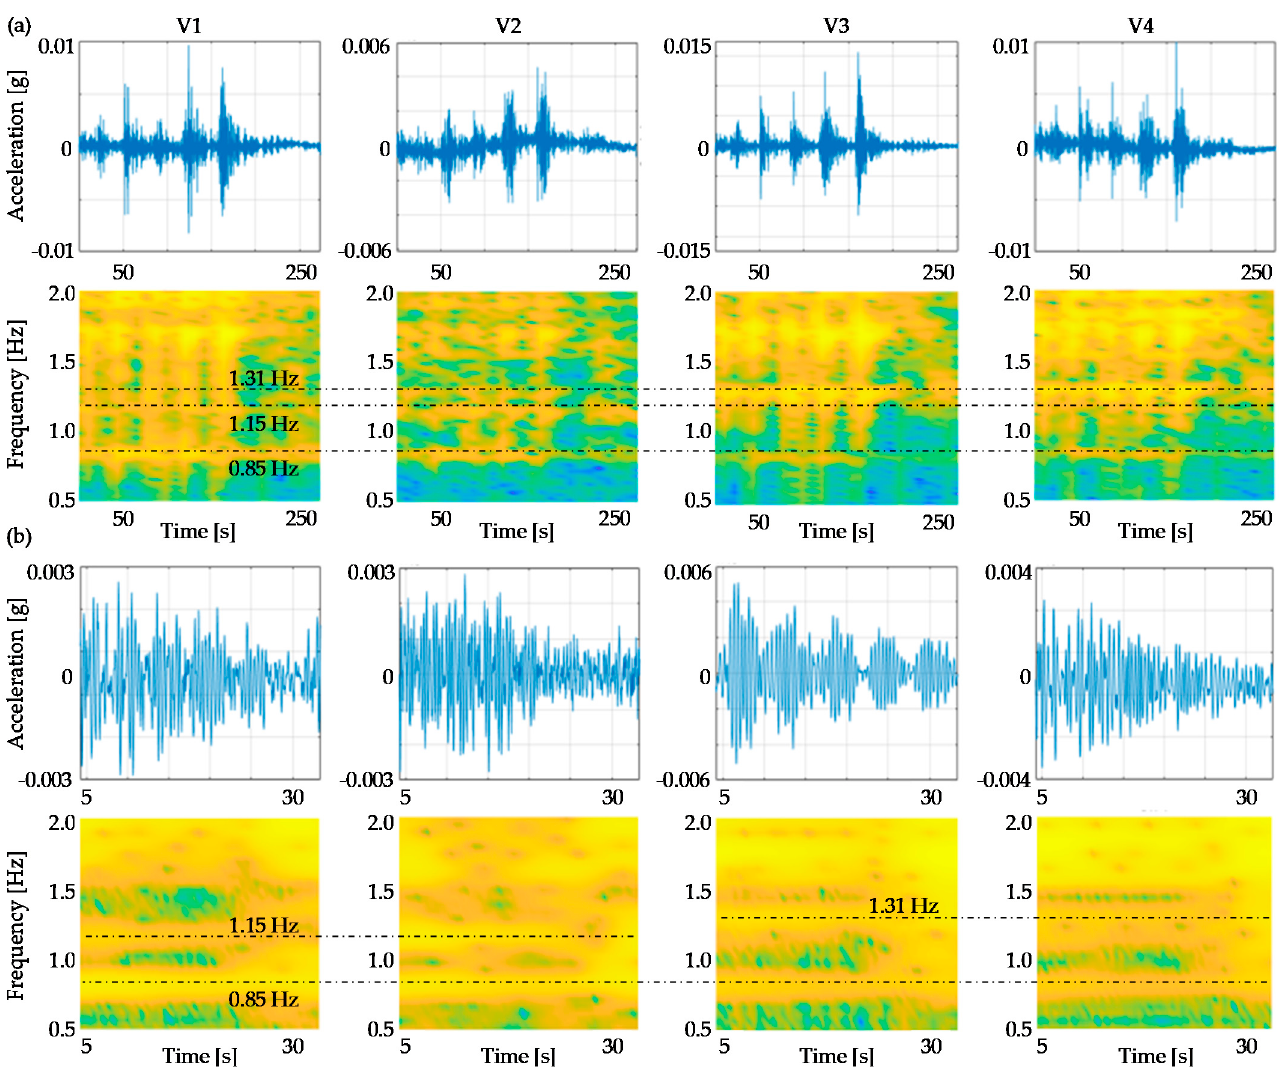
Figure 19. Acceleration time histories and relevant STFTs during the ILT 2: ( a ) slow truck passage over the bump and ( b ) passage with constant speed.